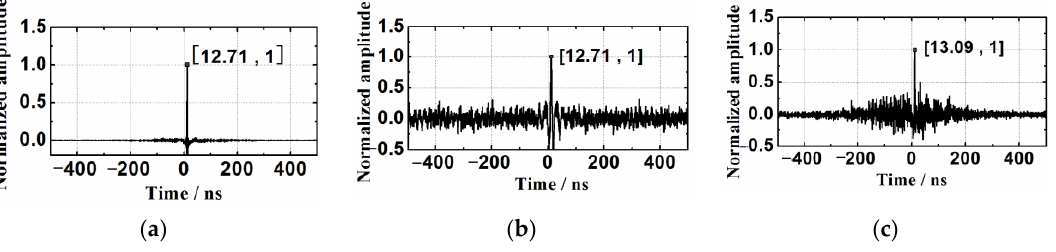
Figure 5. Comparison of time delay results using: ( a ) Method 1; ( b ) Method 2; ( c ) Method 3. N = 10, SNR with Gaussian noise = 10 dB. N is the number of